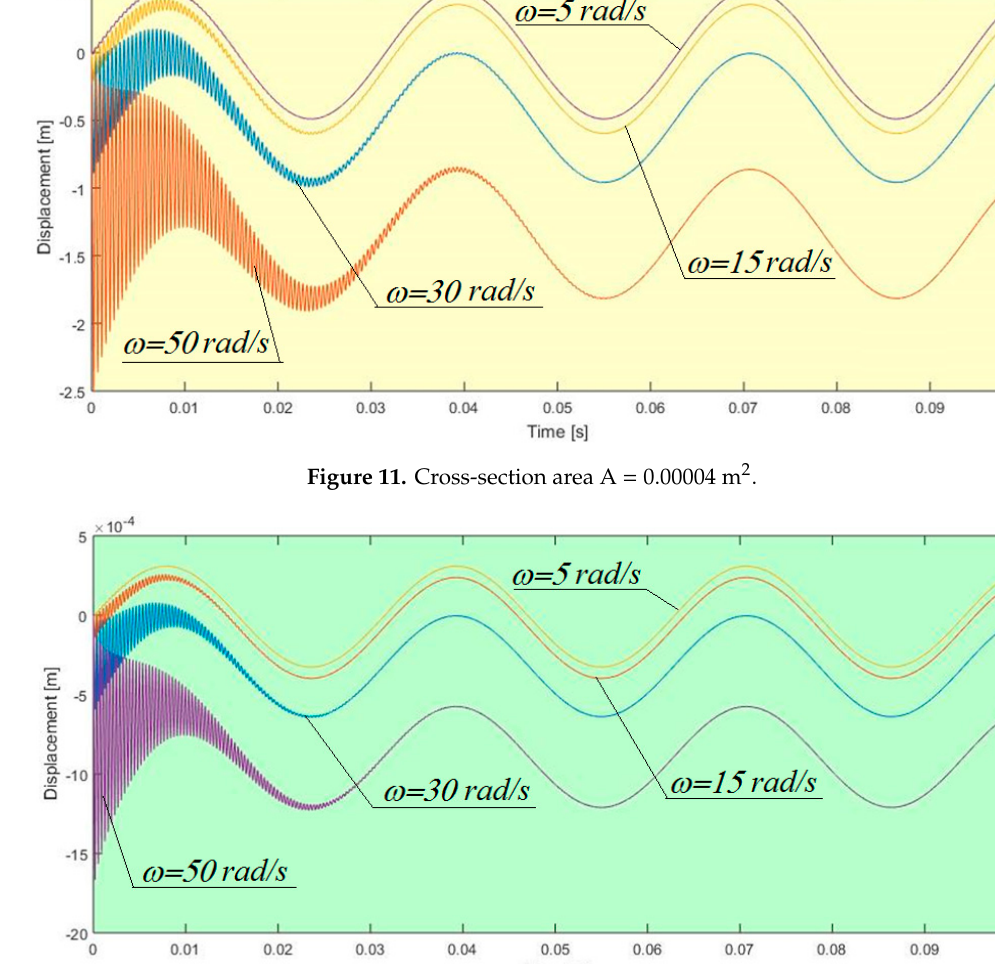
Figure 10. Cross-section area A = 0.00002 m 2 .